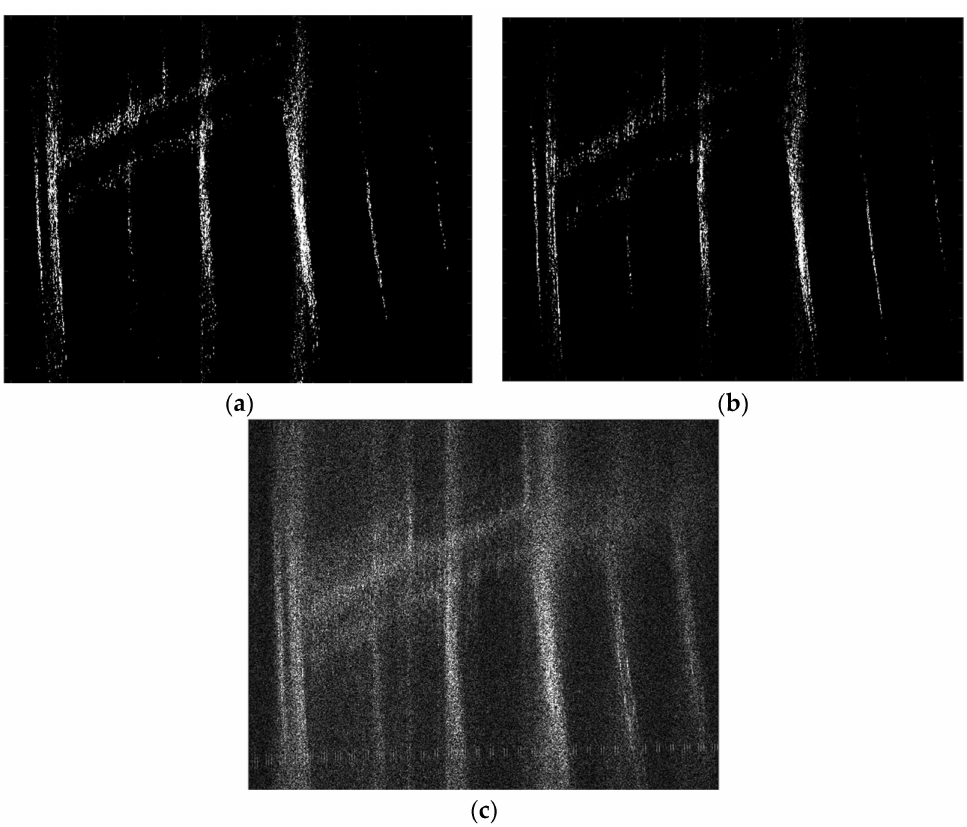
Figure 9. The imaging results of each algorithm with an undersampling rate of 0.3: ( a ) Algorithm 1, ( b ) Algorithm 2, ( c ) Direct